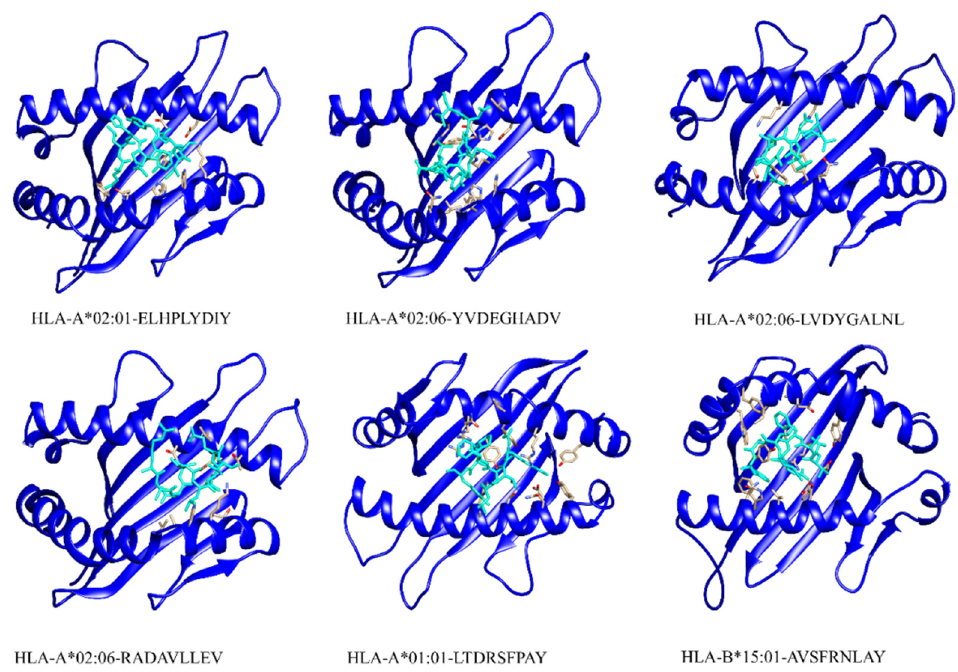
Figure 3. Selected CTL epitopes’ docking complexes with respective HLAs. The epitope is shown in a cyan color whereas the human leukocyte antigens are presented in a dark blue color.